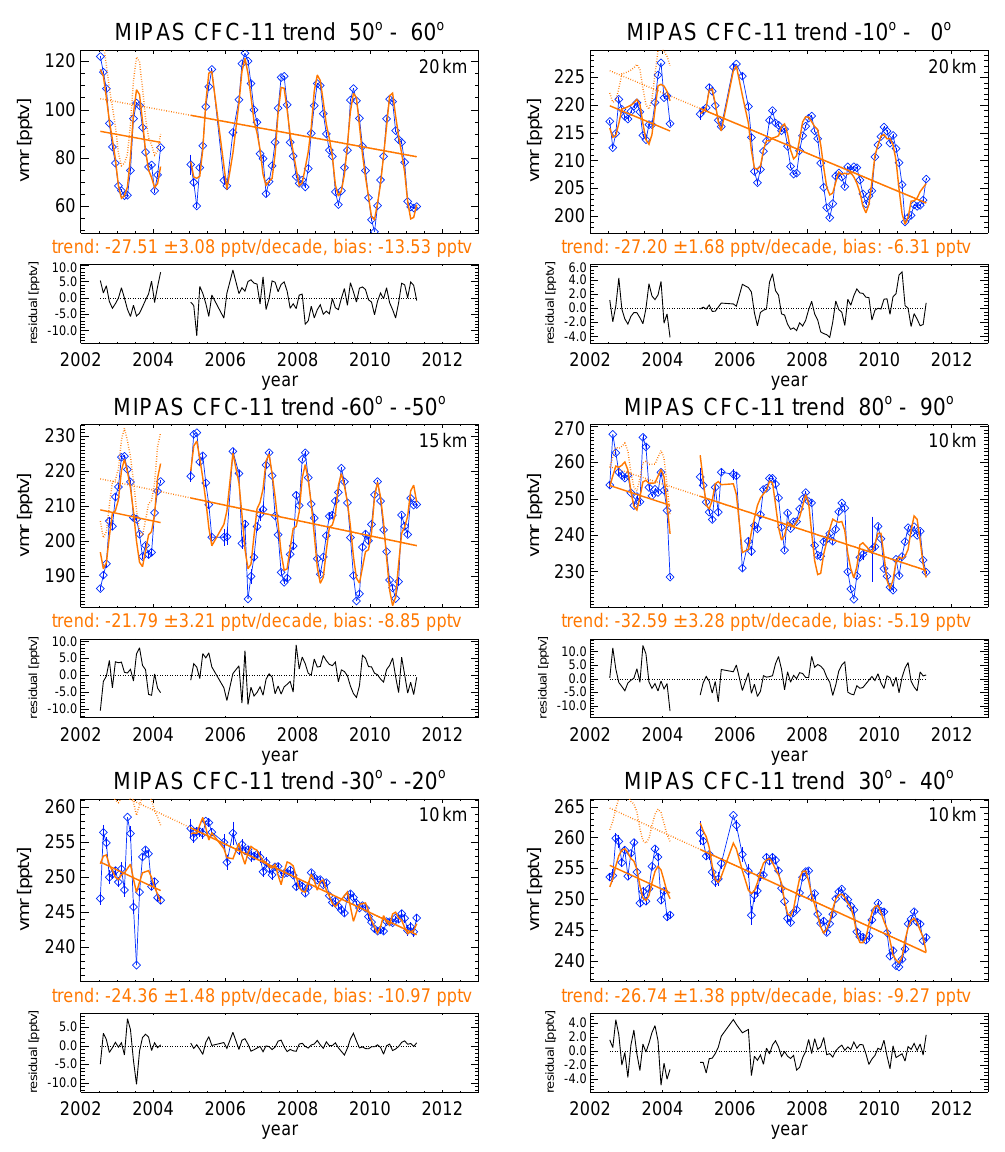
Fig. 11. Temporal evolution of CFC-11 for northern mid-latitudes (50 ◦ N to 60 ◦ N) at 20 km (top left panel), inner tropics (0 ◦ S to 10 ◦ S) at 20 km (top right panel), southern mid-latitudes (50 ◦ S to 60 ◦ S) at 15 km altitude (middle left panel), northern polar latitudes (80 ◦ N to 90 ◦ N) at 10 km altitude (middle right panel), southern subtropics (20 ◦ S to 30 ◦ S) at 10 km altitude (lower right panel), and northern mid-latitudes (30 ◦ N to 40 ◦ N) at 10 km (lower right panel), The blue diamonds are the MIPAS data points; the bold solid orange curve is the fit through the data. The linear part of the regression represented by the straight orange line. The dotted orange curve and straight line are the respective bias-corrected fit and its linear component, respectively. In the lower part of each panel, the residuals between MIPAS CFC-11 monthly zonal means and the trend-corrected regression function are shown. The trend of CFC-11 in pptv per decade, its uncertainty, and the bias between the data subsets FR and RR are printed in orange font.